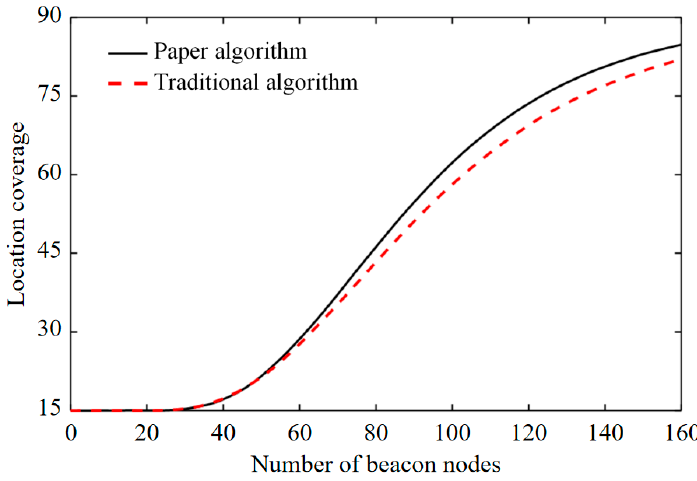
Figure 9. Location